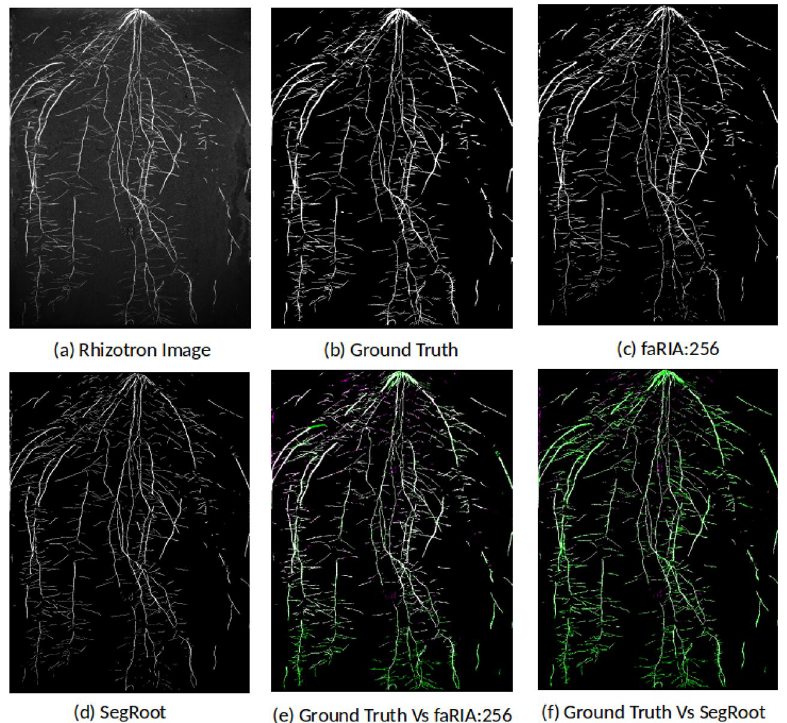
Figure 9. Applicability of faRIA on rhizotron soil-root images: ( a ) image of barley plant roots at lateral stage, ( b ) ground truth segmentation generated by saRIA, ( c ) predicted segmentation using faRIA:256, ( d ) predicted segmentation using SegRoot, ( e ) overlay of faRIA prediction on ground truth with DC = 0.87, ( f ) overlay of SegRoot prediction on ground truth with DC = 0.73. Green, pink and white colour pixels represents false negatives, false positives and correctly segmented pixels in the predicted image with respect to ground truth